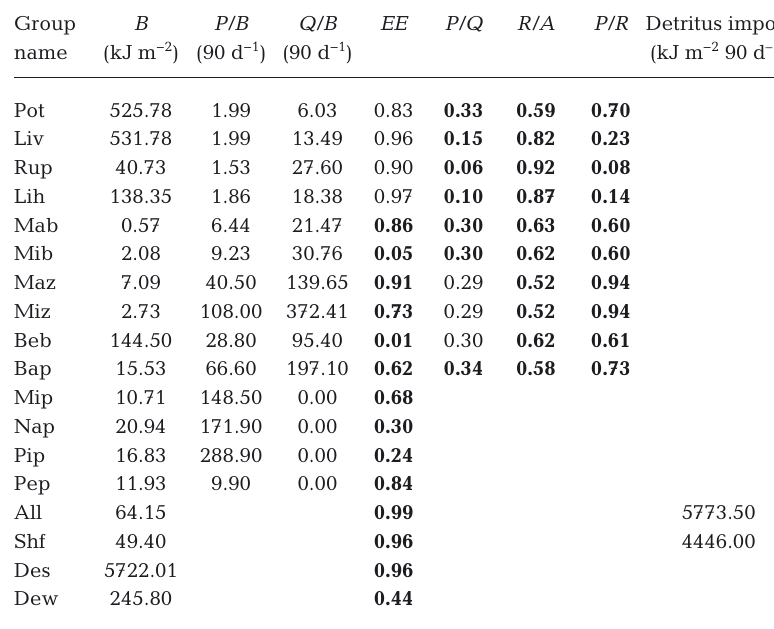
Table 2. Ecopath outputs for the 4-species polyculture ecosystem model. Values in bold are the parameters estimated by the model. Group abbreviations as in Table 1. B : biomass; P/B : production/biomass; Q/B : consumption/biomass; EE : ecotrophic effi- ciency; P/Q : production/consumption; R/A : respiration/assimilation; P/R : production/